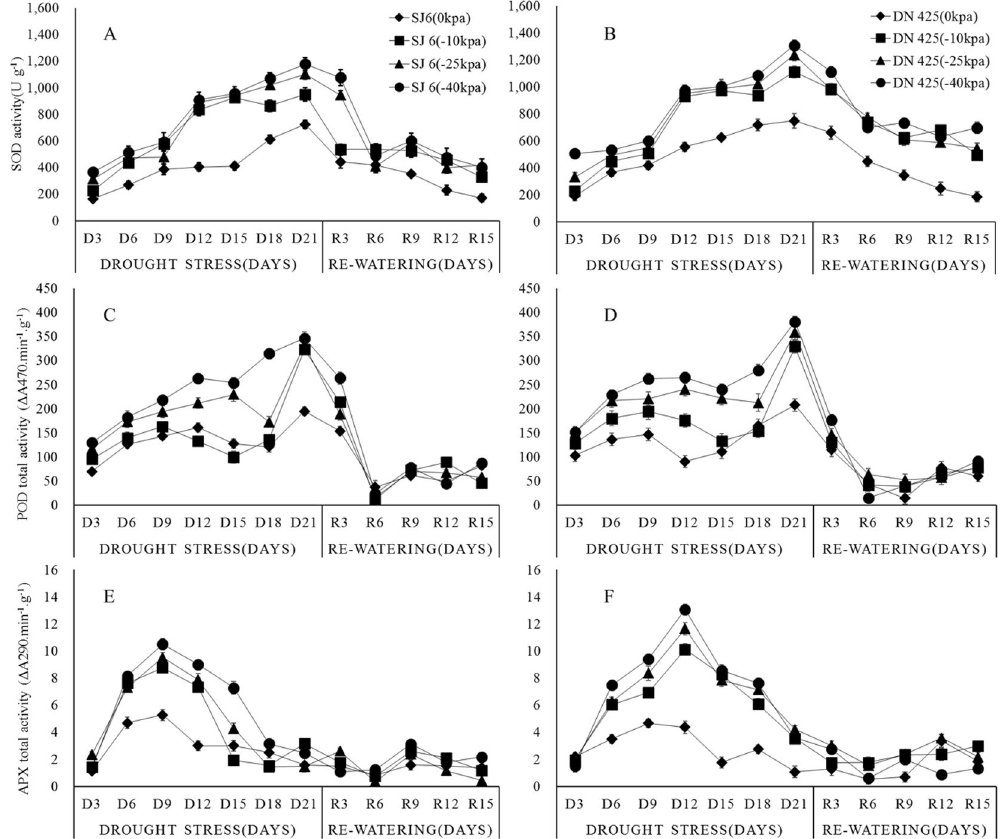
Figure 1. Effects of drought stress and re-watering on SOD ( A , B ), POD ( C , D ) and APX ( E , D ) activity in leaves at tillering stage of two rice cultivars in all treatments.SJ6, Songjing 6 (drought-sensitive); DN425, Dongnong 425 (drought-tolerant). The values represent the means ± SD (n = 3). The experiment was conducted